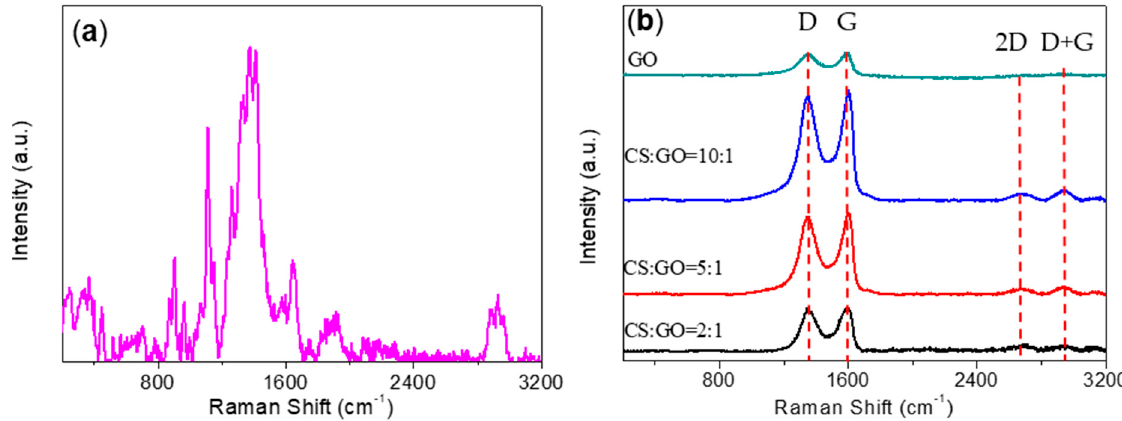
Figure 6. Raman spectra for ( a ) CS, ( b ) GO powder, and CS:GO nanocomposites. Table 1. Summary results of Raman analysis for GO and CS:GO nanocomposites.